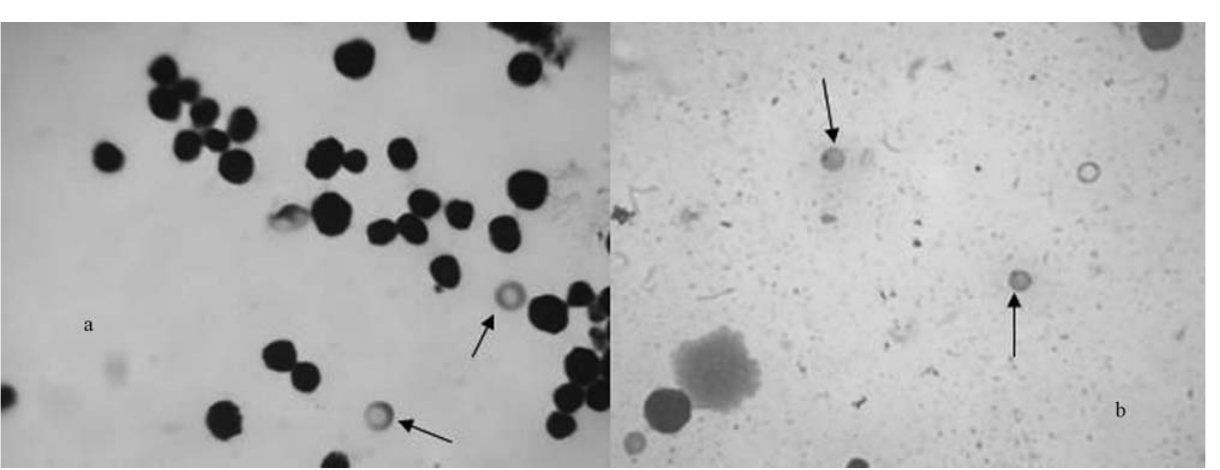
Figure 3 - Micronuclei (MN) induced in mice exposed to the pharmaceutical effluent (a) Normal Polychromatic erythrocyte (b) Micronucleated Poly- chromatic Erythocyte (MNPCE). Magnification